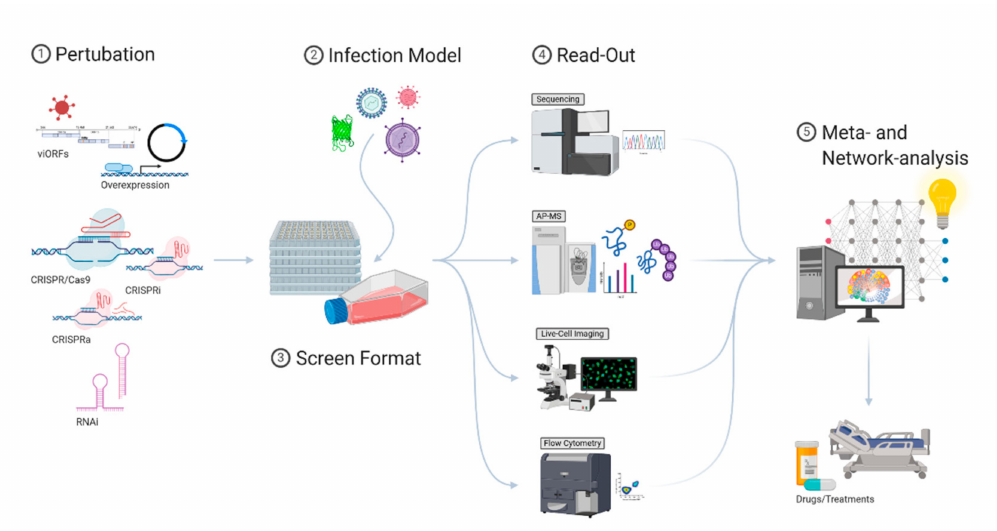
Figure 2. An extensive portfolio of genetic perturbation approaches (1) can be used to modify the protein expression levels to study the contextual function of specific gene products. With a suitable infection model system (2) (e.g., reporter viruses) and a fitting screening format (3), a large number of target genes can be studied on a large scale. Several di ff erent methods can then be used as a readout for gene / protein functionality (4). Di ff erent datasets can then be merged and fed into meta- and network-analysis algorithms (5). Gathering detailed insights from di ff erent experimental settings, a global picture of the innate immunity landscape can be drawn. It is critical to understand virus–host interactions in detail to develop novel antiviral drugs and treatments at the time they are